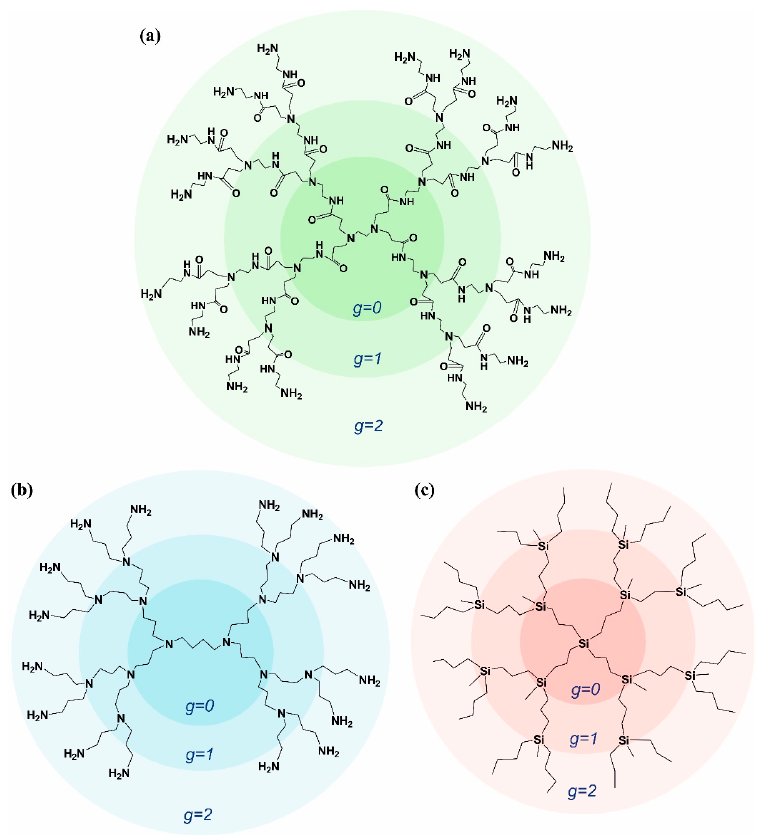
Figure 1. Structures of the second generation dendrimers (G = 2, with 16 terminal groups) ( a ) polyamidoamine (PAMAM), ( b ) polypropylene imine (PPI) and ( c ) polycarbosilane (PCS) dendrimers. g is the generation layer number.